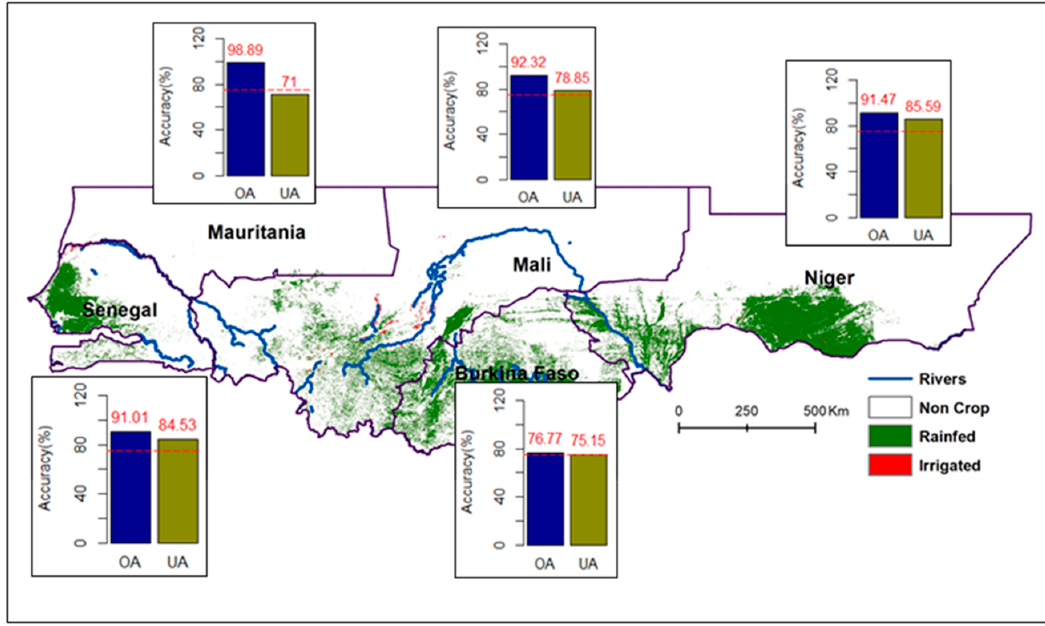
Figure 6. Overall accuracy and user’s accuracy by country.